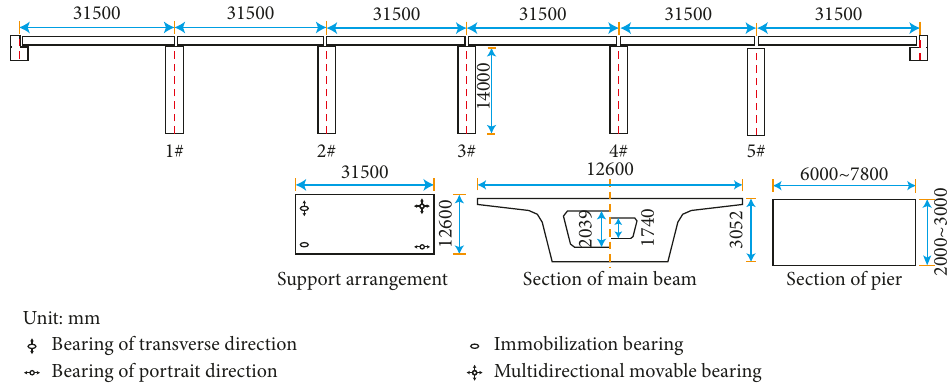
Figure 1: Schematic view of the railway